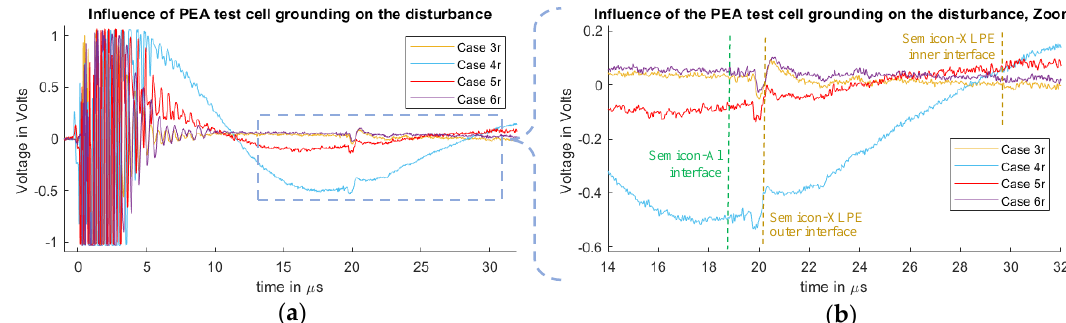
Figure 11. Measured disturbance from Cases 3r, 4r, 5r and 6r. ( a ) Full measured signal ranging from the instant of the pulsed voltage application up to 32 µs. ( b ) Zoom to the time instant of the acoustic signal arrival belonging to the charge measurements.